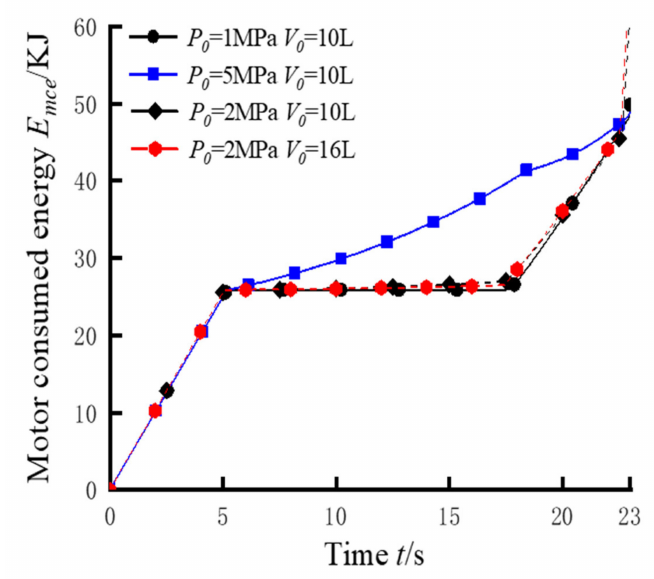
Figure 16. Motor energy consumption under different initial charging pressures P 0 of accumulator and the volumes V 0 of accumulator.